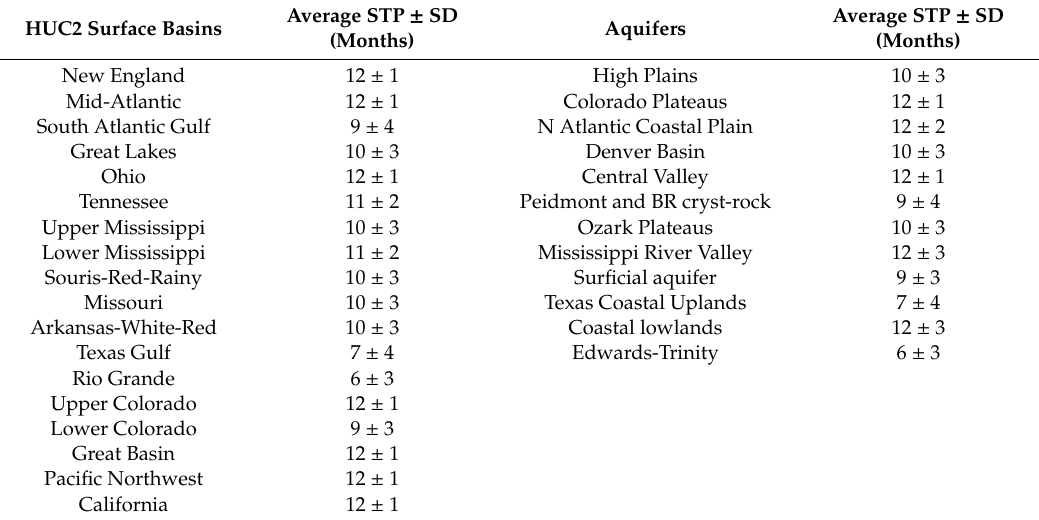
Table 2. Estimates of average storage cycle (STP) and ± standard deviation (SD) in months derived for surface basins and aquifers using GRACE TWSA.